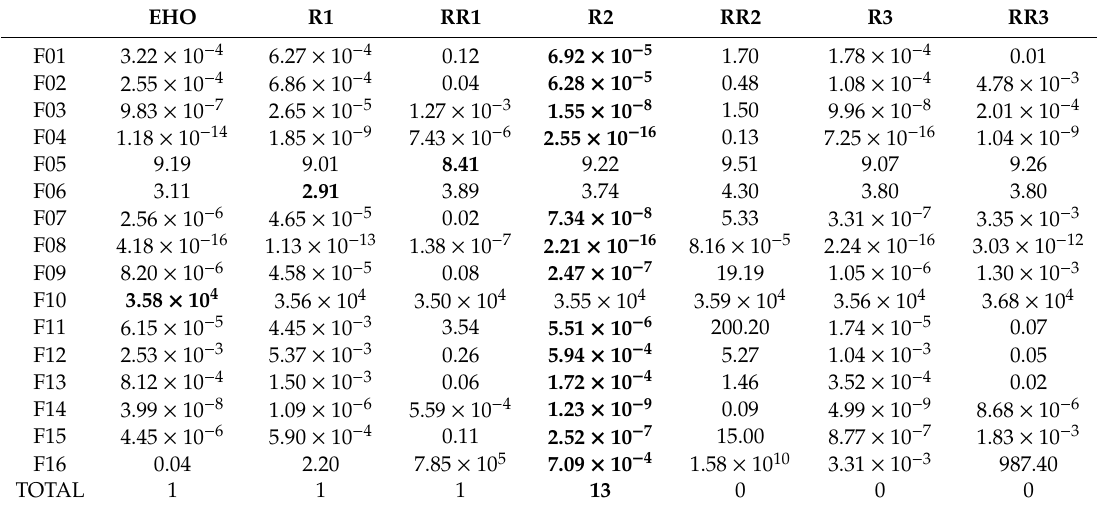
Table 4. Mean function values obtained by EHO and six improved methods with D = 100.